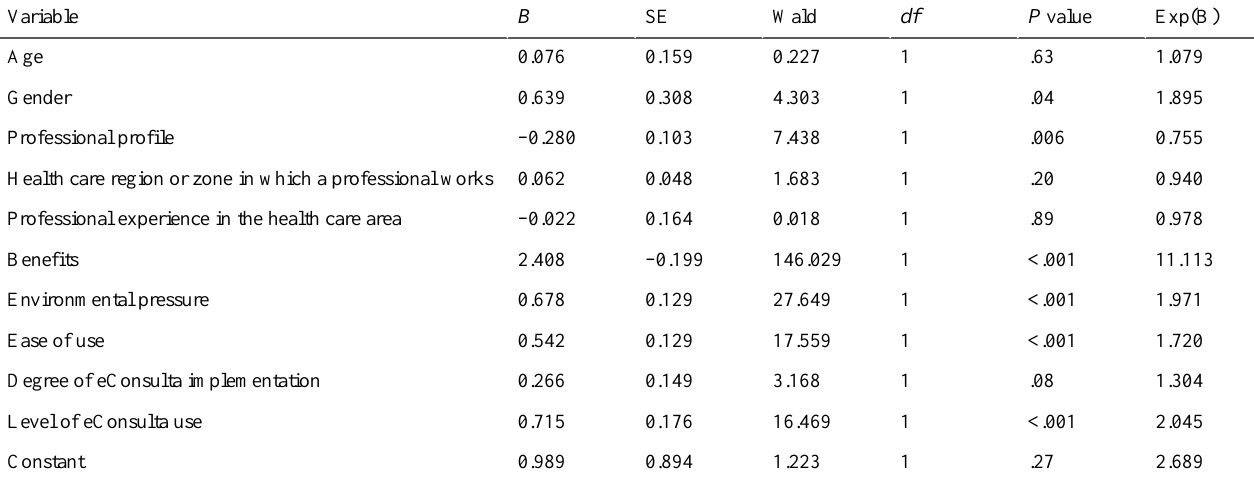
Table 3. Logistic regression on eConsulta